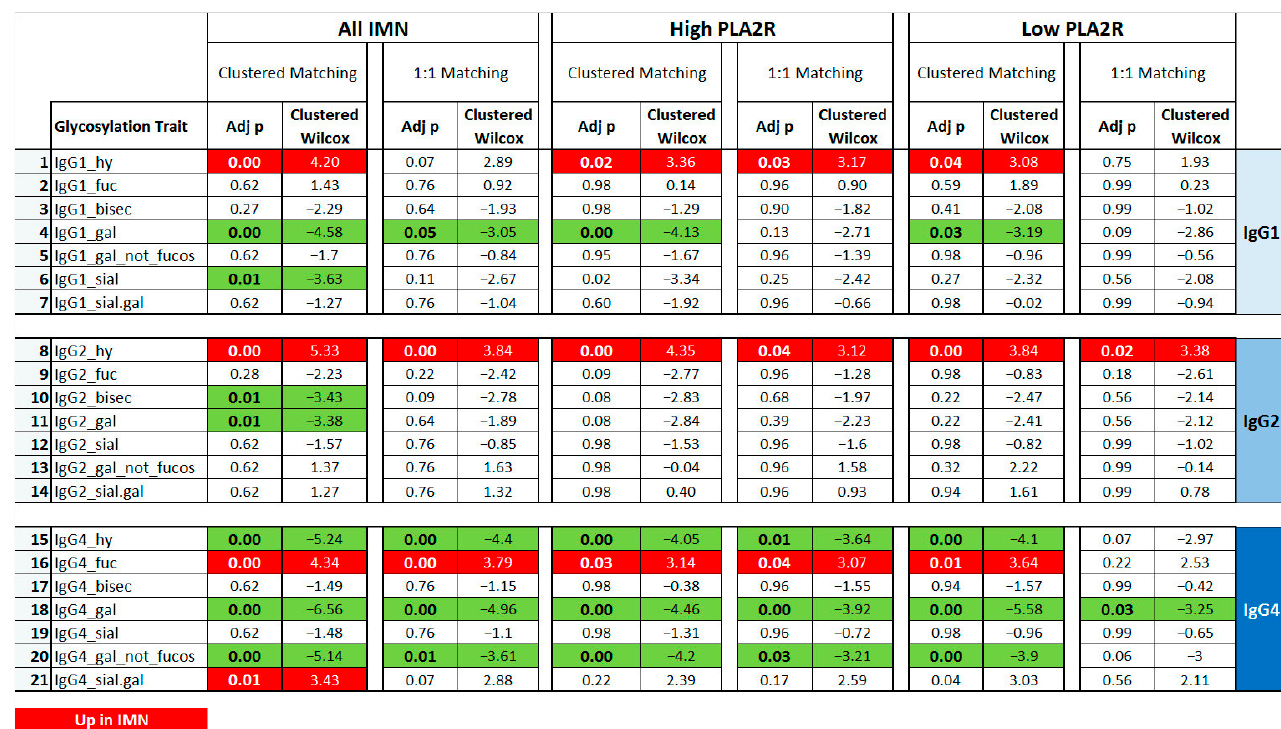
Figure 3. Comparisons between IMN patients and matched controls considering the seven glycosylation traits* for each IgG subclass (1, 2 and 4). Matching was performed using a clustered or one-to-one approach. The IMN patients were used all together ( ALL IMN ) or based on PLA2R titer ( HighPLA2R if > 999; Low PLA2R if < 999). Green and bold indicate significant ( p < 0.05) lower levels In IMN patients, while red and bold refers to significant ( p < 0.05) higher levels in IMN patients. * hy = hybrid glycoforms; fuc = with fucosylation; bisec = with bisection; gal = with galactosylation; sial = with sialylation; gal_not fucos = galactosylation of non-fucosylated glycoforms; sial.gal = sialylation per galactose.